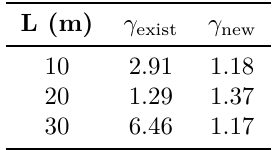
Table 2. Existing and proposed safety factor for run- ning safety of high-speed ballastless railway